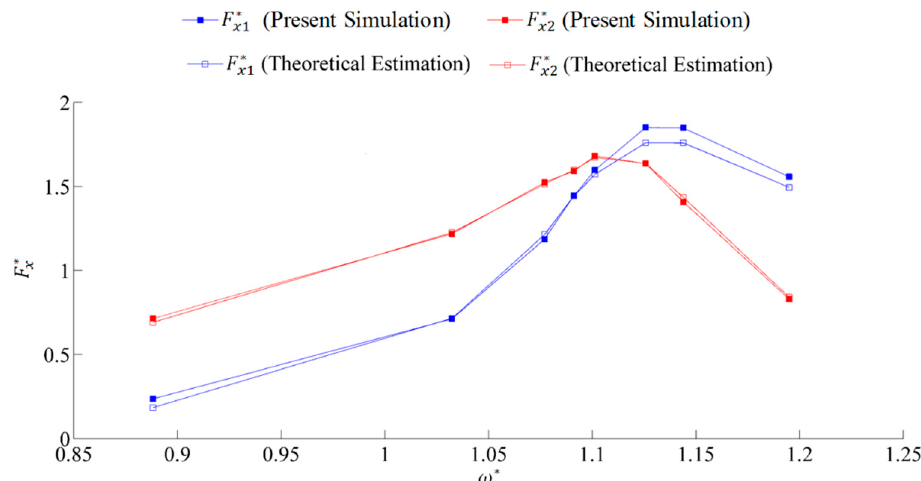
Figure 22. The variation tendencies of the horizontal force amplitudes are well predicted by the theoretical estimations based on Equations (30) and (31) ( B ∗ g = 0.17).